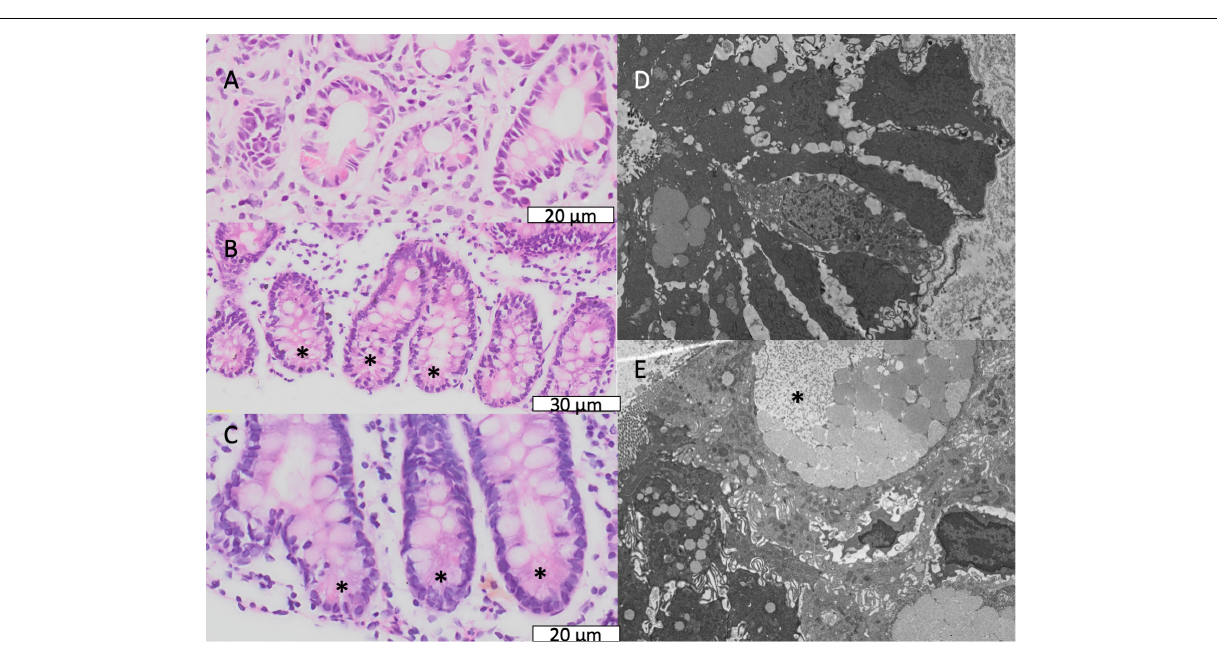
Zambia have surprisingly severe environmental enteropathy with pronounced epithelial leakiness. Only 2 out of 75 children had Watson scores of 1, which contrasts sharply with grade 1 scores